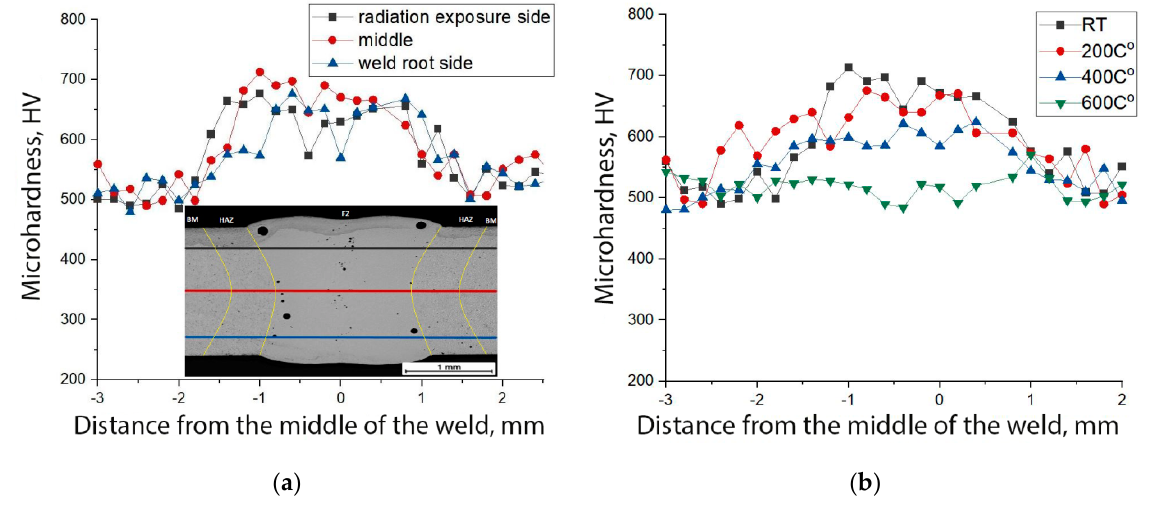
Figure 7. Microhardness profiles across the weld obtained ( a ) without pre-heating; the microhardness was measured along radiation exposure side (black line), half-thickness (red line), and weld root side (blue line); ( b ) at different pre-heating temperature; the microhardness was measured at the midthickness.